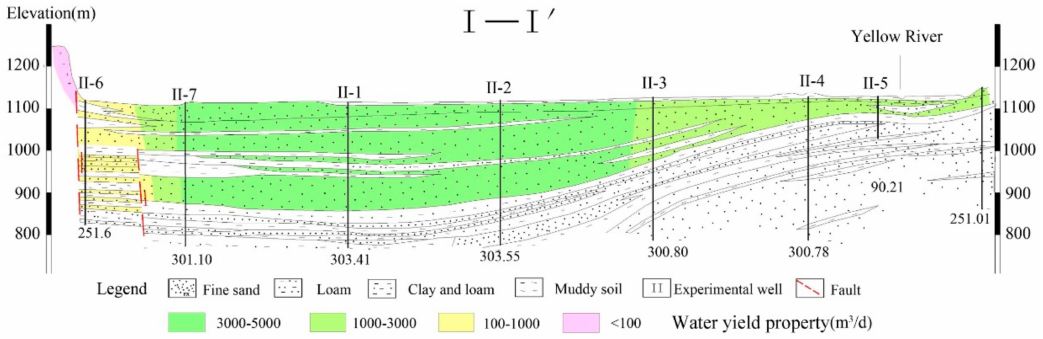
Figure 2. Lithological cross section of the study